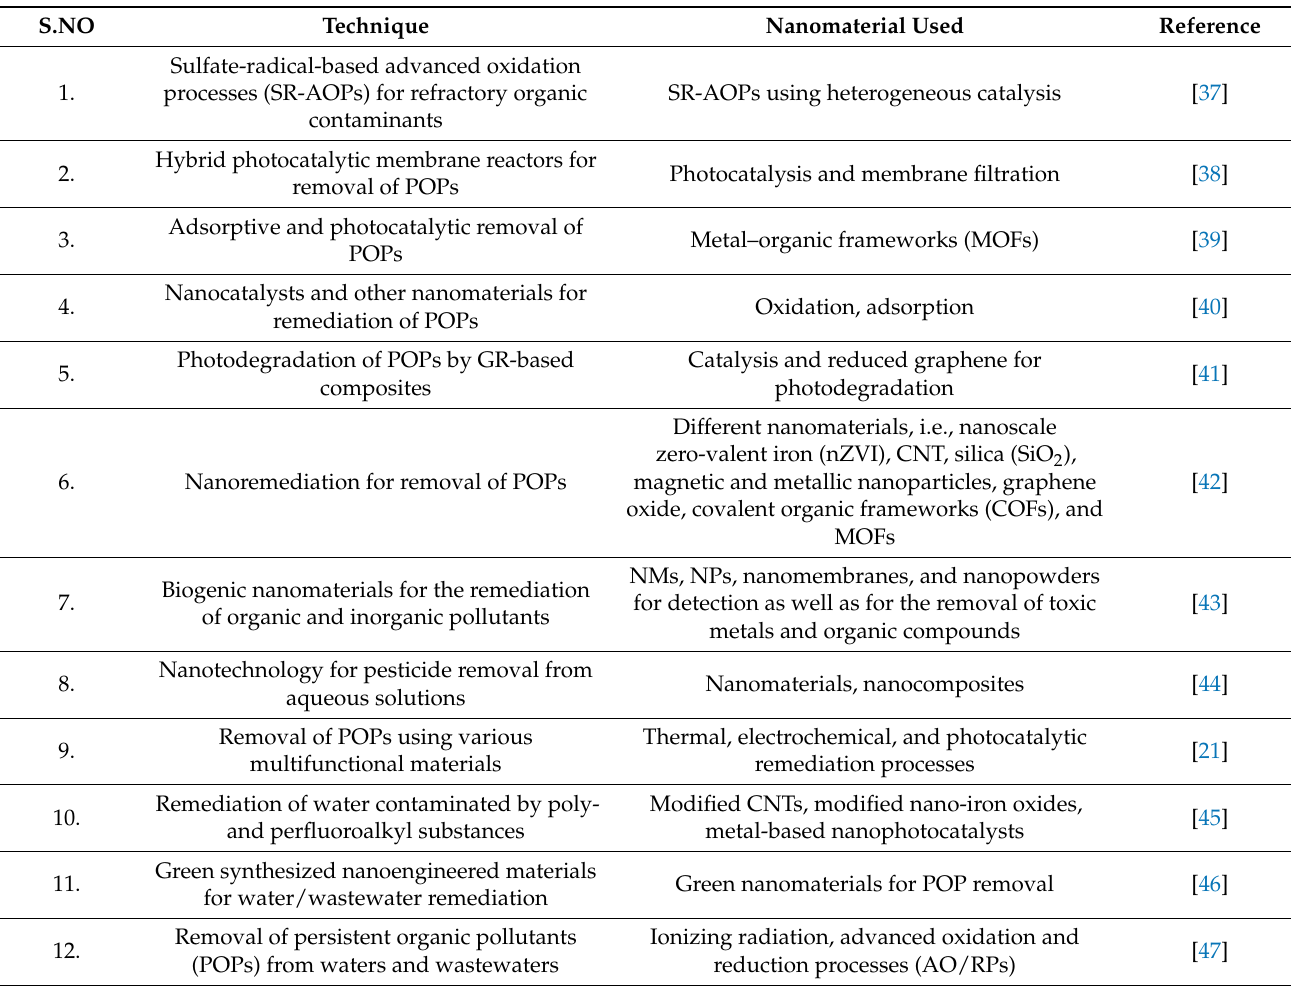
Table 3. Reviews in the field of POP removal using different nano-based